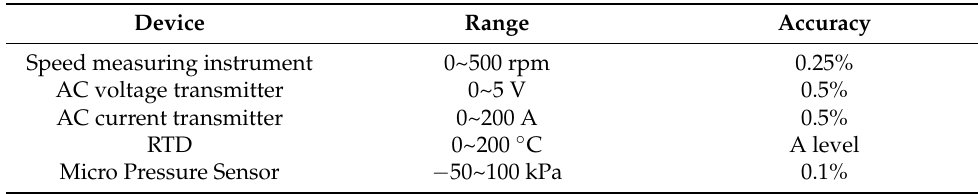
Table 1. Summary of measurement devices.